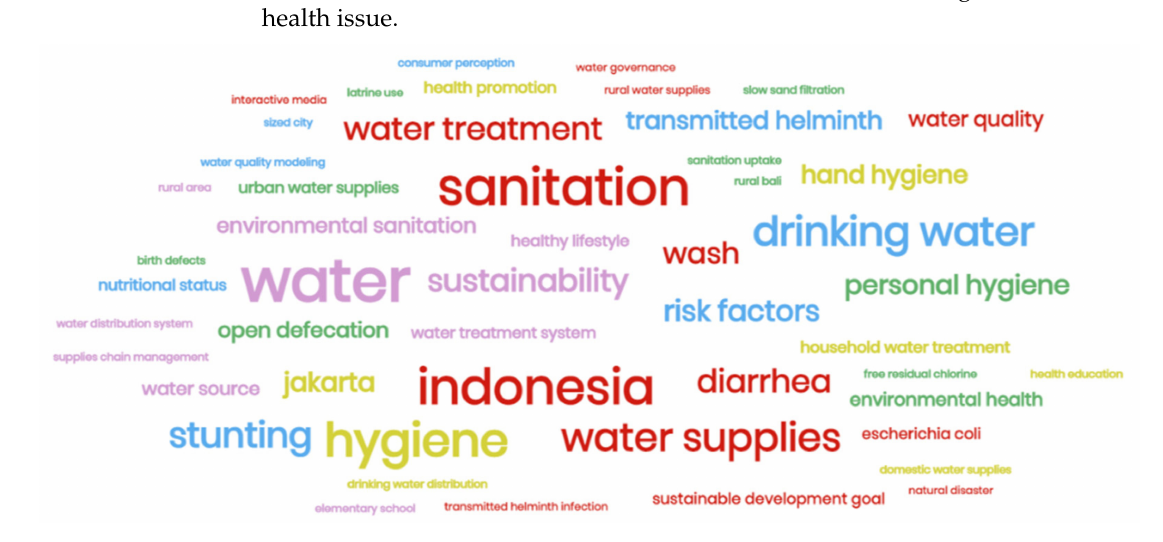
Figure 5. The word cloud of WASH research in Indonesia.